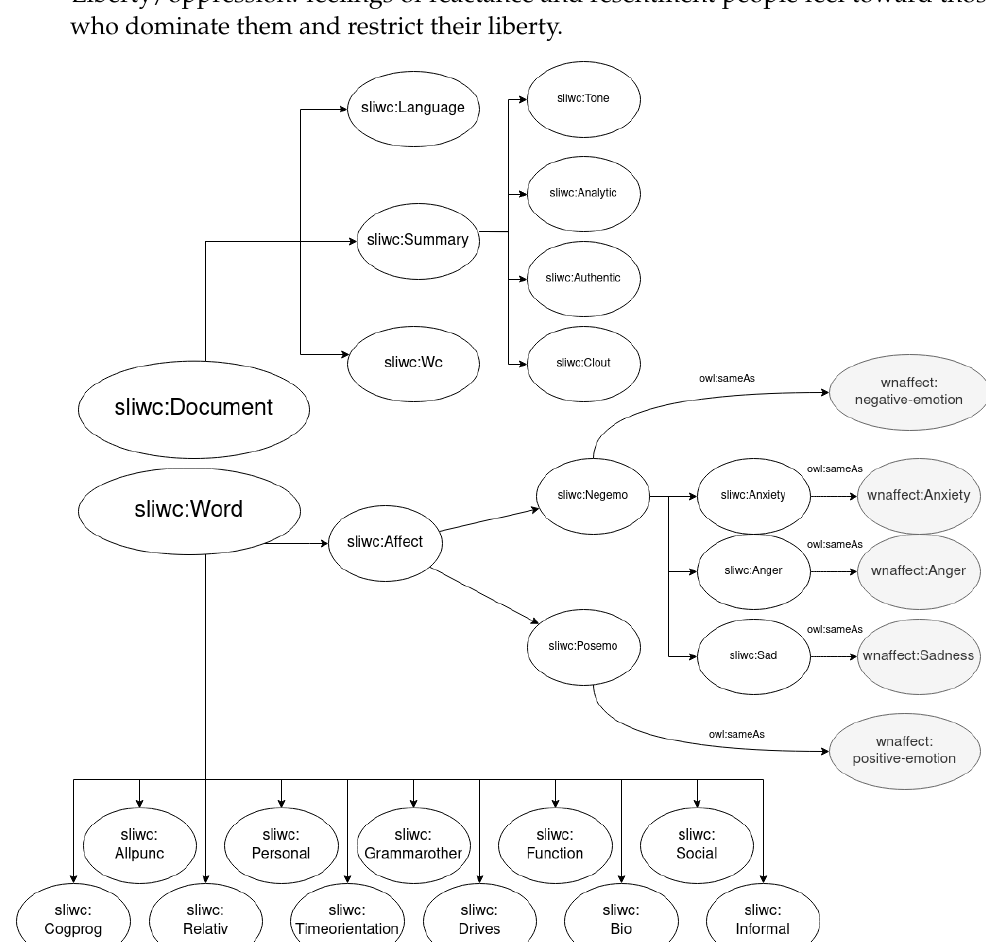
Figure 2. SLIWC taxonomy, simplified, focusing on its connection to WordNet-Affect. Dimensions are represented in different font sizes to emphasize their hierarchical